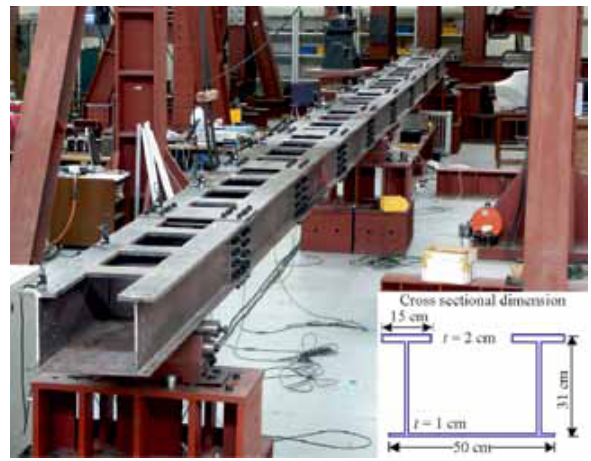
Fig. 2. Experimental setup and cross-section dimensions (Koo et al. 2008)